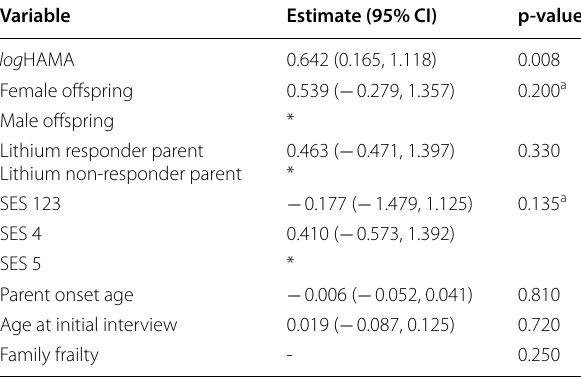
Table 3 Cox model with frailty (n confidence